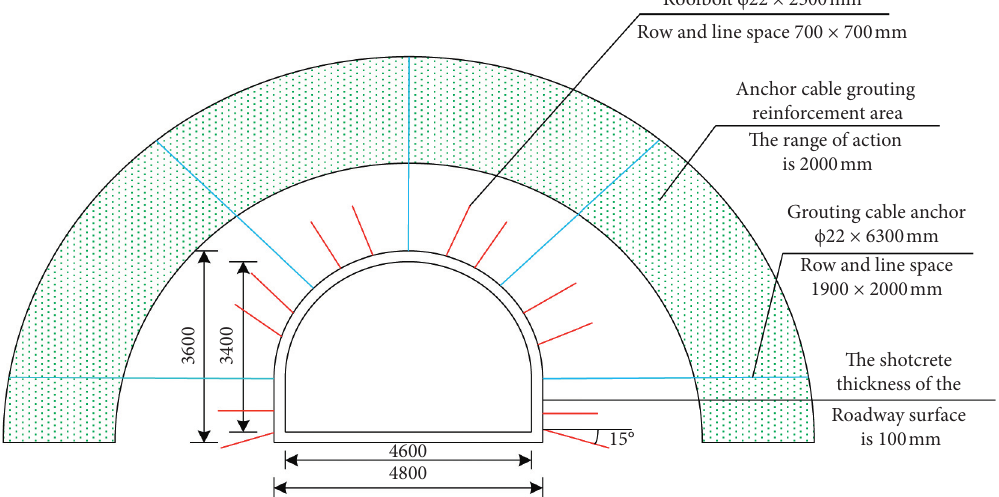
Figure 9: Schematic diagram of reinforcement and support +original support.